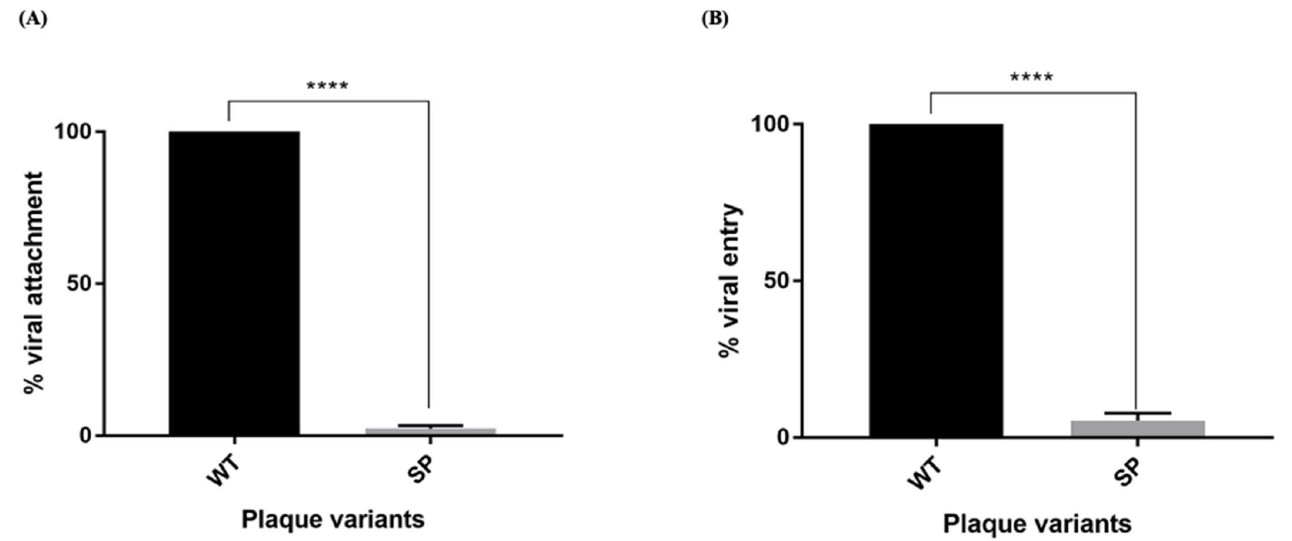
Figure 9. ( A ) Viral attachment and ( B ) viral entry of the EV-A71/SP variant, corresponding with the EV-A71/WT. The experiment was conducted as three independent experiments and the average value is presented. Error bars indicate standard deviation of average. Statistical analysis, unpaired t -test, **** p < 0.0001.